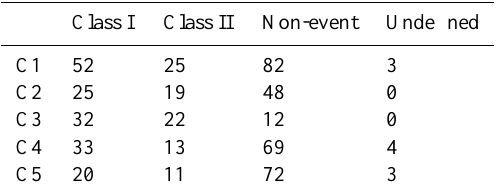
Table 3. Statistics of NPF events in different air mass